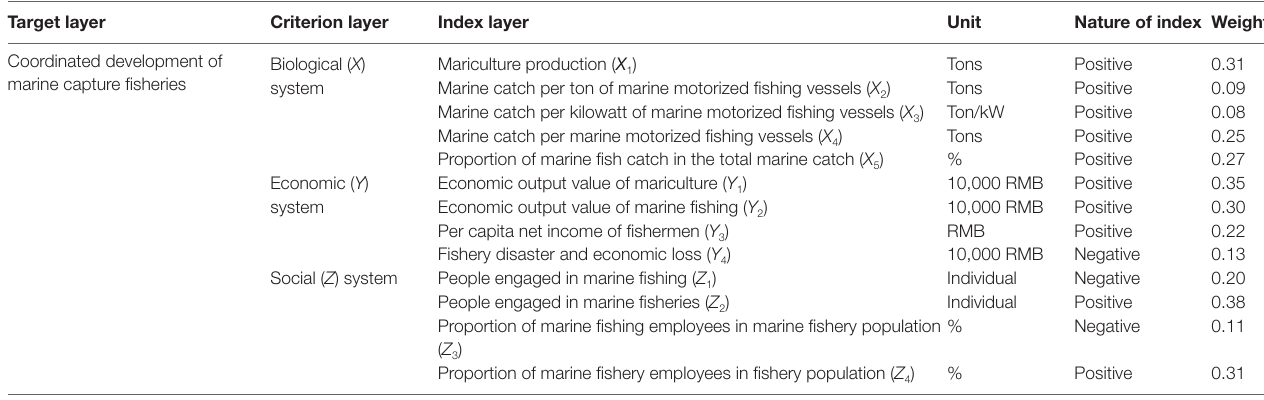
TABLE 1 | Index system of sustainable utilization of marine capture